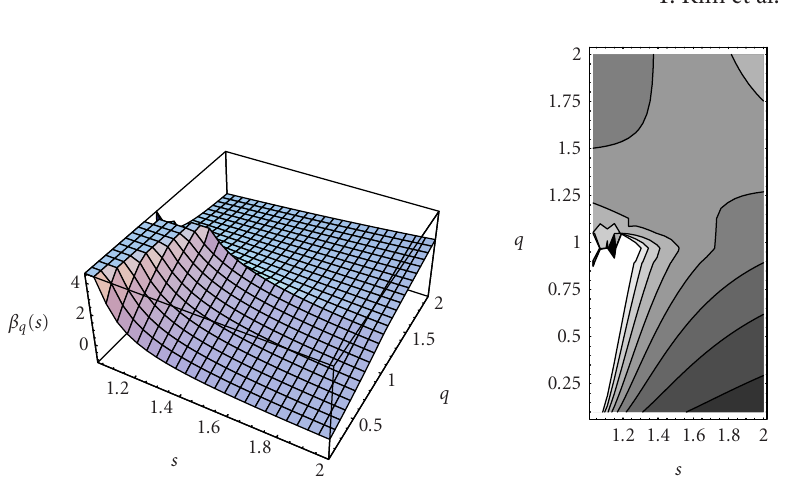
Figure 4.2. The plot of β q ( s ), 1 . 03 ≤ s ≤ 2, 0 . 1 ≤ q ≤ 2 .